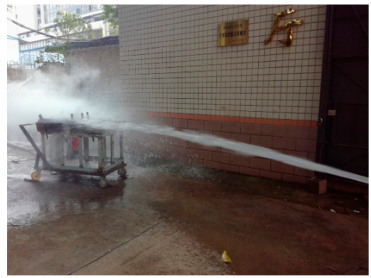
Figure 3. Specimens cooled by fire hydrant after high temperatures exposure.